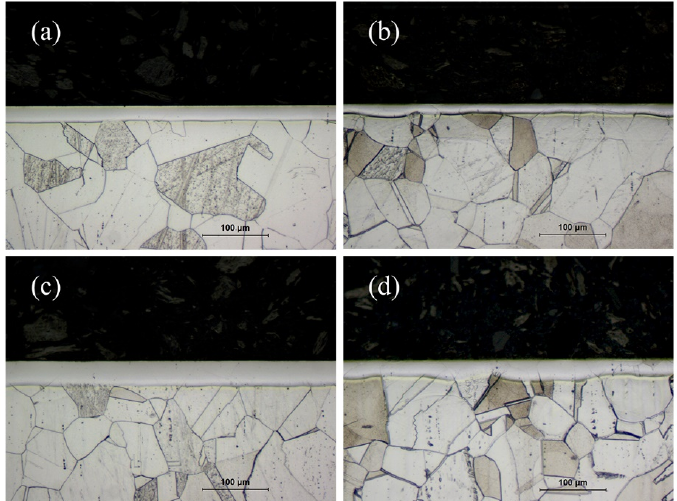
Figure 1. Cross-sectional optical microscope images of the AISI 316L stainless steel (ASS) carburized with various gas mixture ratios of ( a ) 0.05 and ( b ) 10 for 14 h, and ( c ) 1 and ( d ) 10 for 42 h. Figure 2 shows numerical simulation and experimental data obtained by GDOES